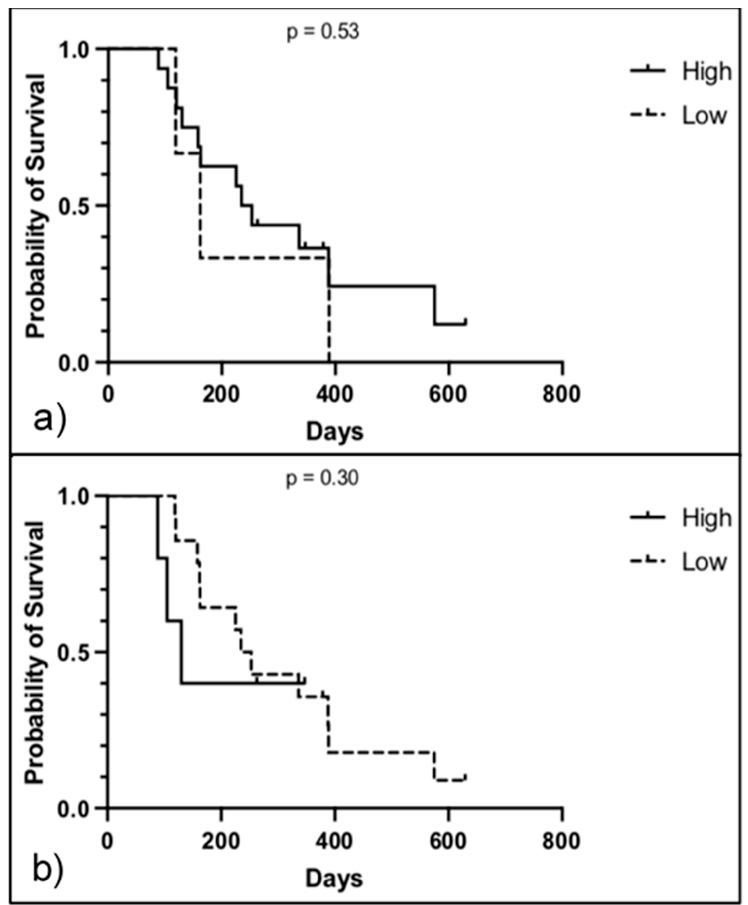
Figure 6. Kaplan–Meier survival analysis of the ITT subset with high and low IFG2R expression. ( a ) Survival analysis of dogs with high versus low IGF2R expression on VIS. Survival time did not differ between high (244 days, 95% CI 43–534) and low (162 days, 95% CI 19–235) VIS ( p = 0.53, Log Rank test; n = 15) ( b ) Survival analysis of dogs with high versus low IGF2R expression on CPD score. Survival time did not differ between high (130 days, 95% CI 15–189) and low (244 days, 95% CI 53–665) CPD score ( p = 0.58, Log Rank test; n = 15).